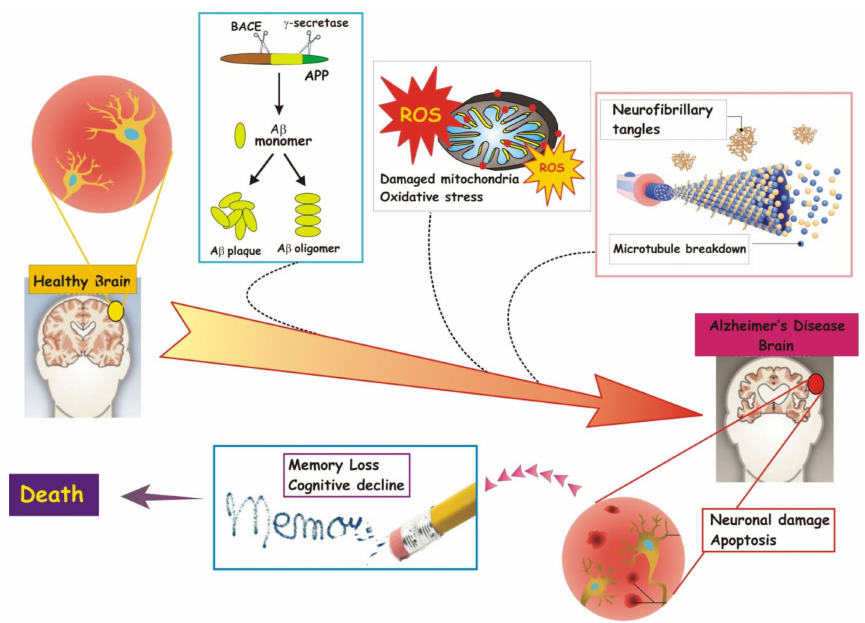
Figure 2. Major events, namely oxidative stress and mitochondrial dysfunction, toxicity and aggregation of A β and tau, neuronal damage and apoptosis, memory loss and cognitive decline, characterizing the onset and progression of AD until